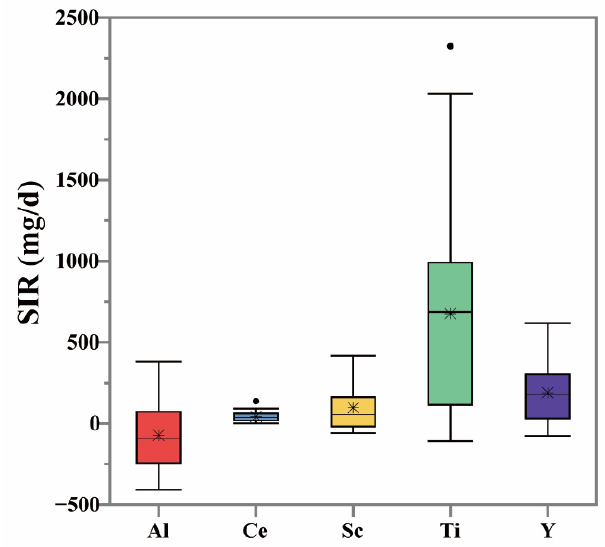
Figure 2. The outlier box plot, minimum, mean, median, and maximum, of SIRs based on the best tracer Al, Ce, Sc, Ti, and Y. The * represents mean values, and dot sign represents outliers.